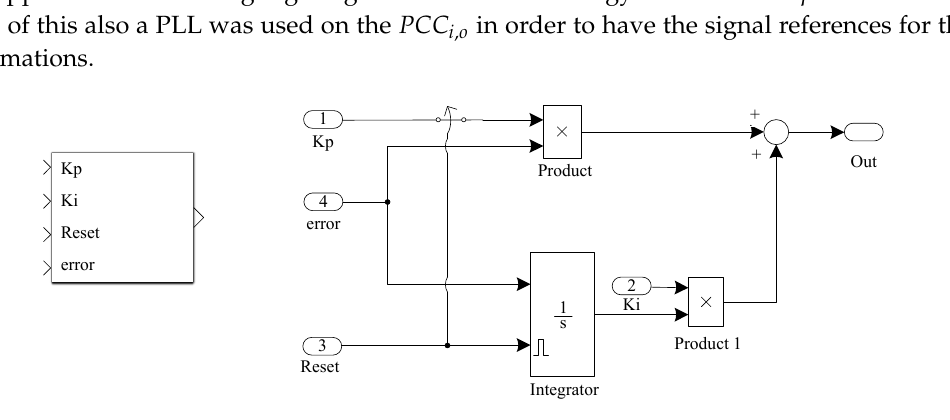
Figure 8. Proposed PI controller